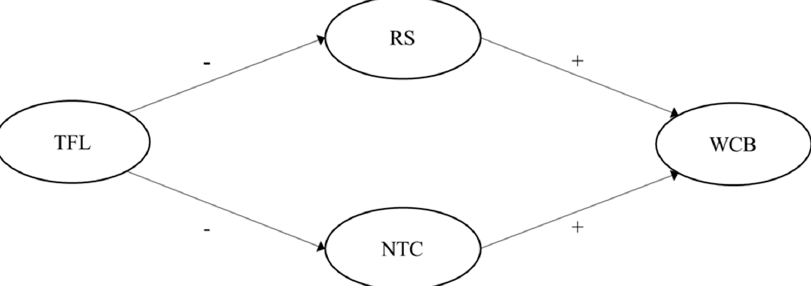
Figure 2. Hypothesized multiple mediation model for transformational leadership on perceived WCB through role stress and negative team climate. Note: TFL = Transformational leadership; RS = Role stress; NTC = Negative team climate; WCB = Workplace cyberbullying.